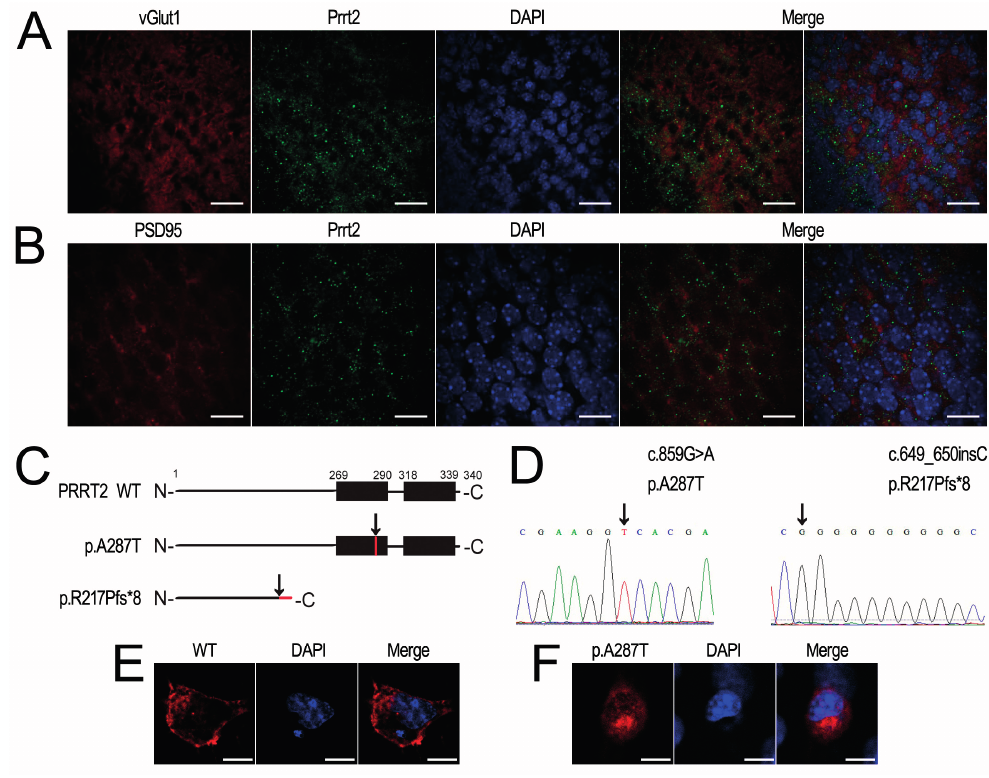
Figure 3. Prrt2 colocalized with presynaptic and postsynaptic markers of glutamatergic neurons of mouse cortex. ( A , B ) Prrt2 (green) colocalized with both vGlut1 (red) and PSD95 (red) in the cortex. Scale bar, 20 μ m; ( C ) Schematic diagram illustrates the protein structure of wild type (WT) and the mutant type (p.A287T and p.R217Pfs*8) of PRRT2. Black rectangles represent two putative C -terminal TM domains of PRRT2. Black arrows indicate the positions of mutations. Red lines represent protein sequence produced by missense or frameshift mutations; ( D ) Sequencing maps of both c.859G>A and c.649_650insC; ( E ) COS-7 cells transfected with Flag-tagged wild type (WT) PRRT2 (red); ( F ) COS-7 cells transfected with Flag-tagged p.A287T PRRT2 (red). Scale bar, 10 μ m. DAPI (blue) was used to show